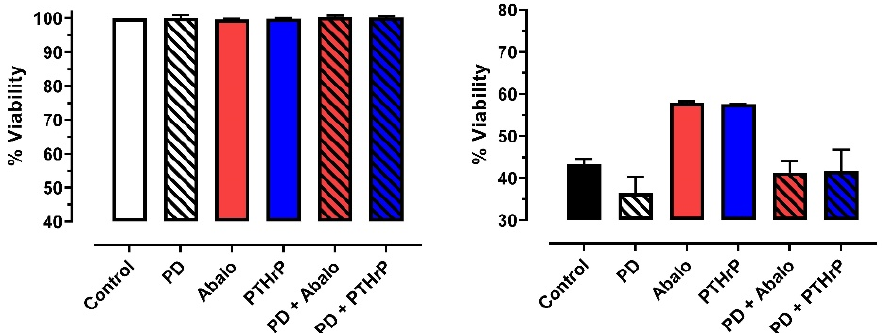
Figure 3. Effect of vehicle, PTHrP(1-36) (PTHrP), abaloparatide (Abalo), PD998059 (PD) + vehicle, PD98059 + PTHrP or PD98059 + Abalo on viability of HL-1 cardiomyocytes maintained under normoxic conditions ( left panel ) or subjected to simulated ischemia-reperfusion ( right panel ). Data reported as mean ± SEM.